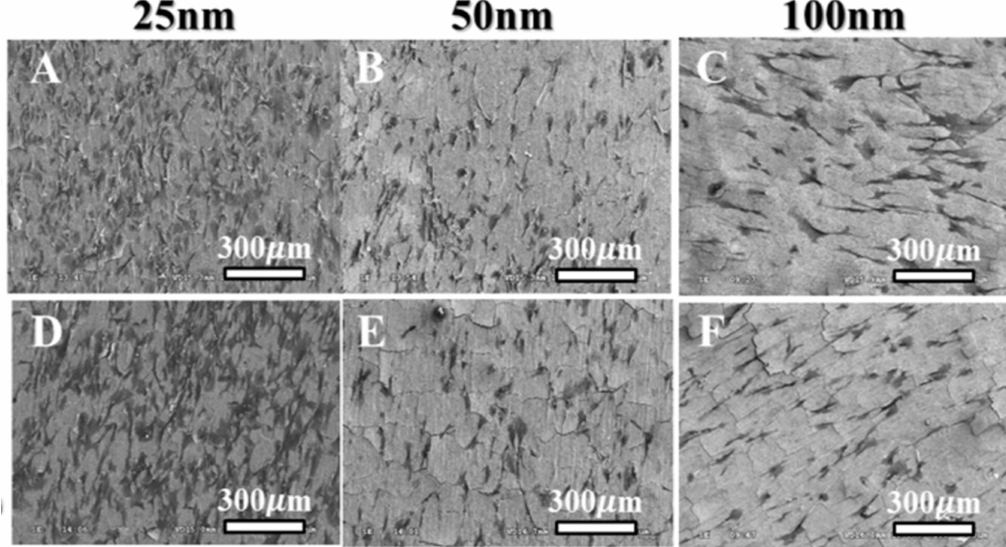
Figure 3. SEM images, showing the cell adhesion and proliferation of human fibroblast cells on the as-grown ( A – C ) and Ag-decorated ( D – F ) TiO 2 nanotubes with the diameters of 25, 50 and 100 nm, respectively. The fibroblasts cultured on the 25-nm-diameter nanotubes revealed good cell adhesion with the development of an elongated cytoskeleton, while those on the 50-nm-diameter or larger nanotubes showed rounded cell morphology with a lack of cell spread in both the as-grown and Ag-decorated samples. (Reproduced with permission from Lan et al., Both Enhanced Biocompatibility and Antibacterial Activity in Ag-Decorated TiO2 Nanotubes; published by PLOS ONE, 2013, CC BY 4.0